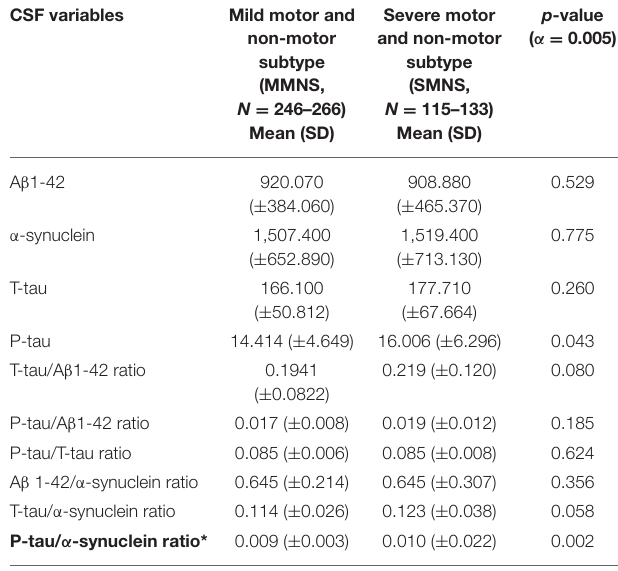
TABLE 2 | Brain imaging of PD subtypes. TABLE 3 | CSF biomarkers of PD